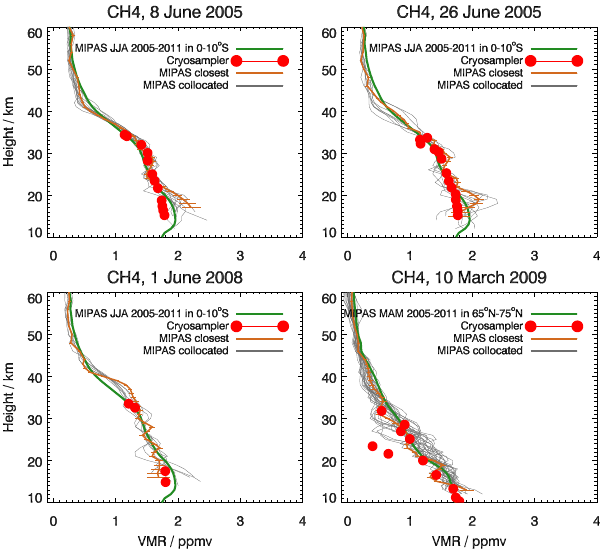
Figure 5. MkIV profiles and MIPAS CH4 vmr vertical profiles – collocated profiles when they exist, otherwise mean profiles in September 2007 and September of 2005–2011 in the 30 ◦ –40 ◦ N latitude band where the three balloon flights took place.